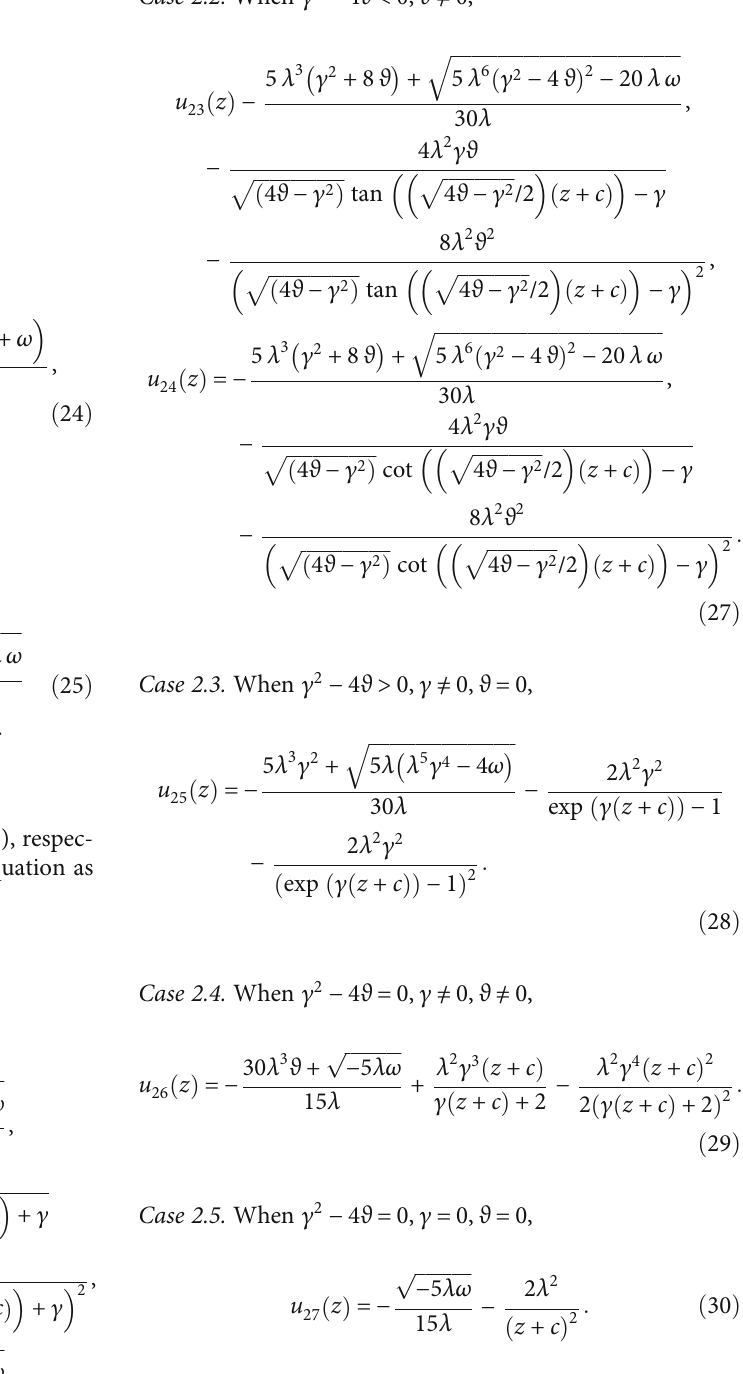
ffiffiffiffiffiffiffiffiffiffiffiffiffiffiffiffiffiffi γ 2 − 4 ϑ ð